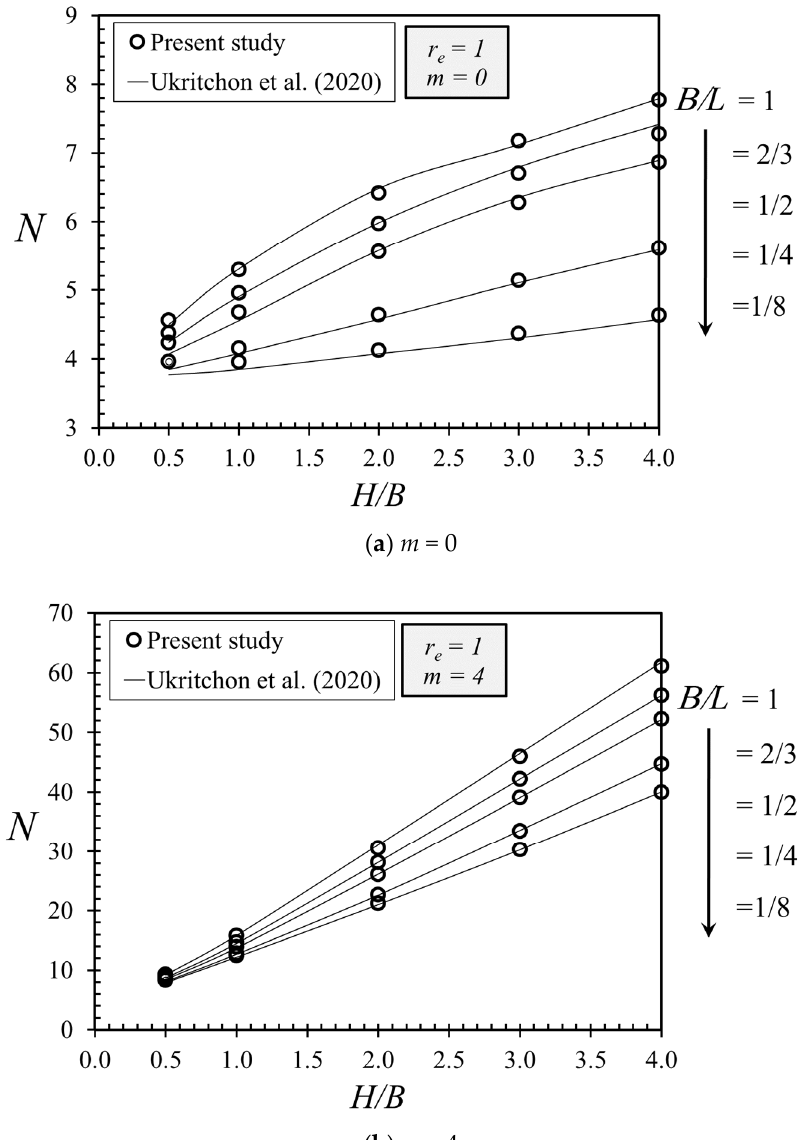
Figure 4. Comparison of stability numbers N ( r e = 1).